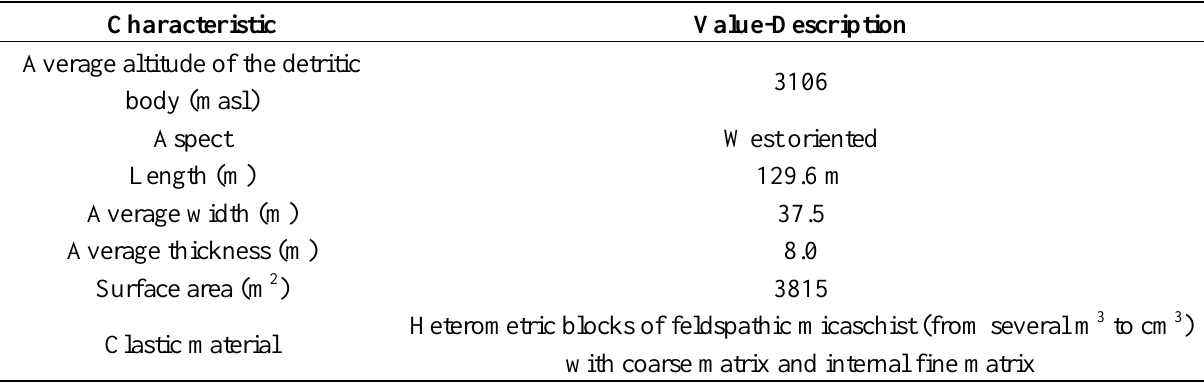
Table 1. Main characteristics of the Corral del Veleta rock